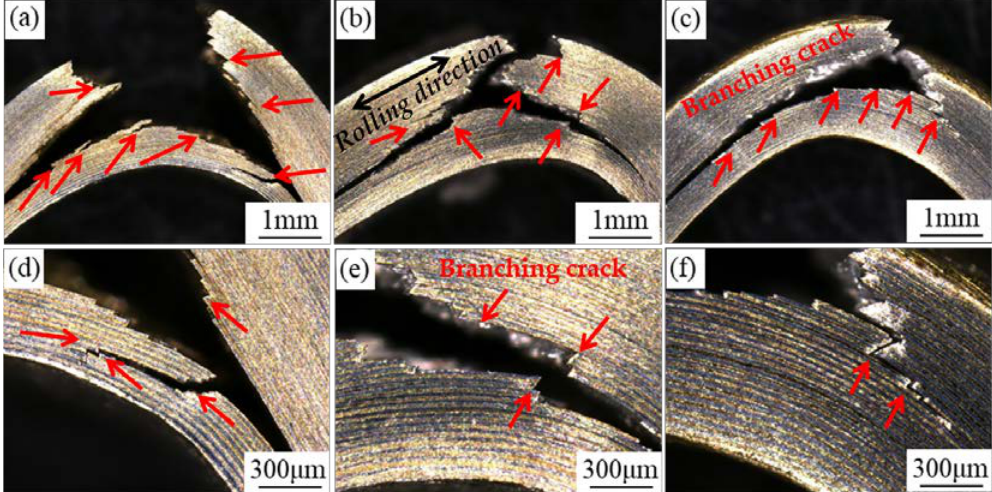
Figure 9. Bending fracture morphology of multilayer composite steel at different rolling temperatures, ( d – f ) is the enlarged view of ( a – c ): ( a ) 400 °C; ( b ) 500 °C; ( c ) 600 °C.